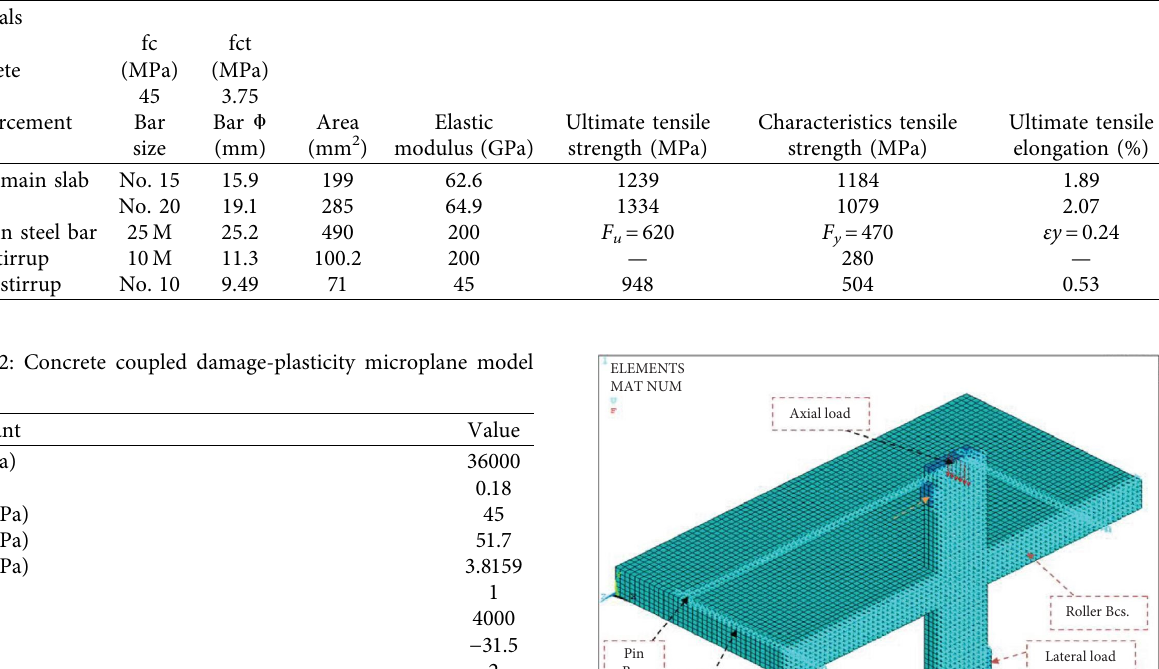
Figure 2: Geometry and reinforcement confguration of part-I slab-column connection specimen [3]. (a) Geometry (mm). (b) Re- inforcement detailing. Table 1: Material properties of concrete, GFRP, and steel rebar reinforcement [3].